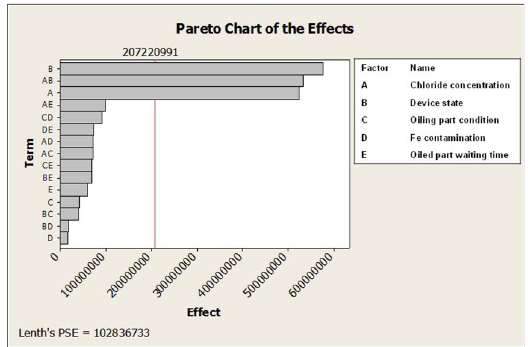
Figure 6. Pareto chart of the effects for the factors and their first order interactions on the ocurrence of corrosion on AA7075-T73 alloy